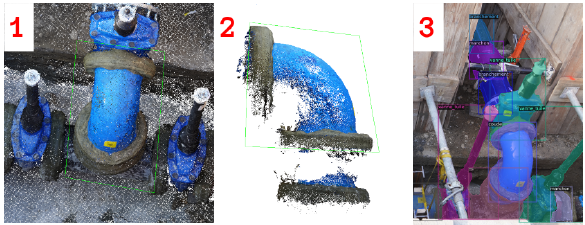
Figure 6: Manual 3D labelling process in only two steps